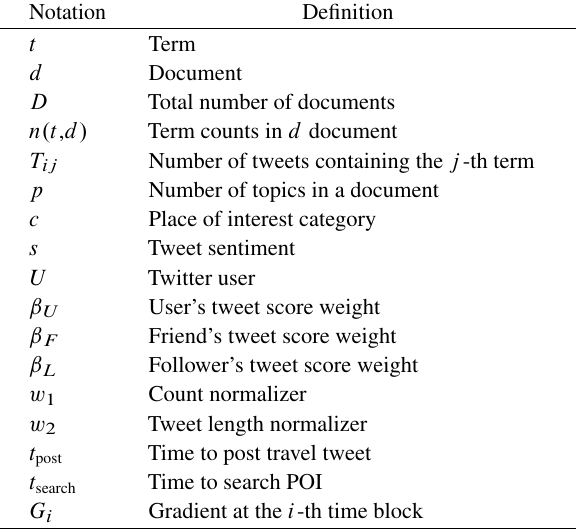
Table 1 Definitions of